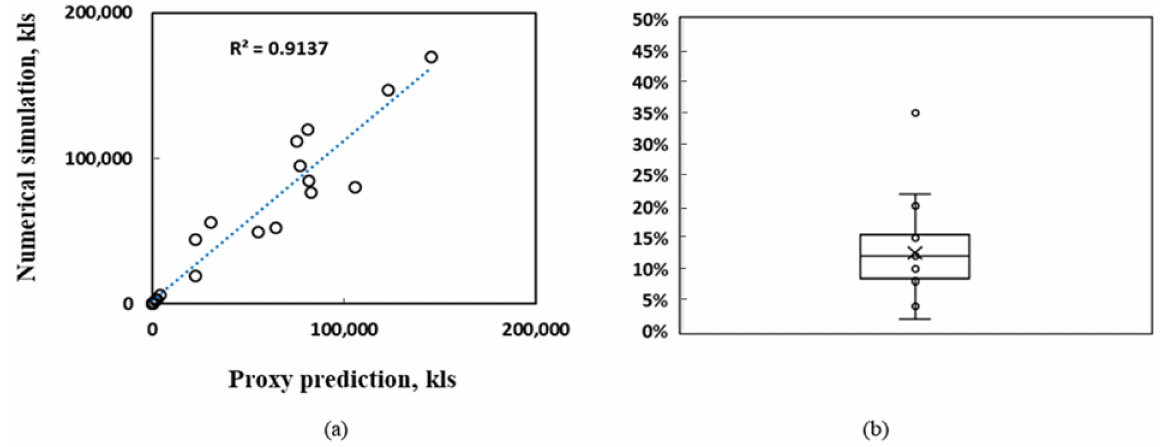
Figure 12. Blind test results using the Stacked learner proxy for incremental oil ( a ). The box and whisker plot ( b ) shows the relative error. The highest error is 35% and the median is 12%.